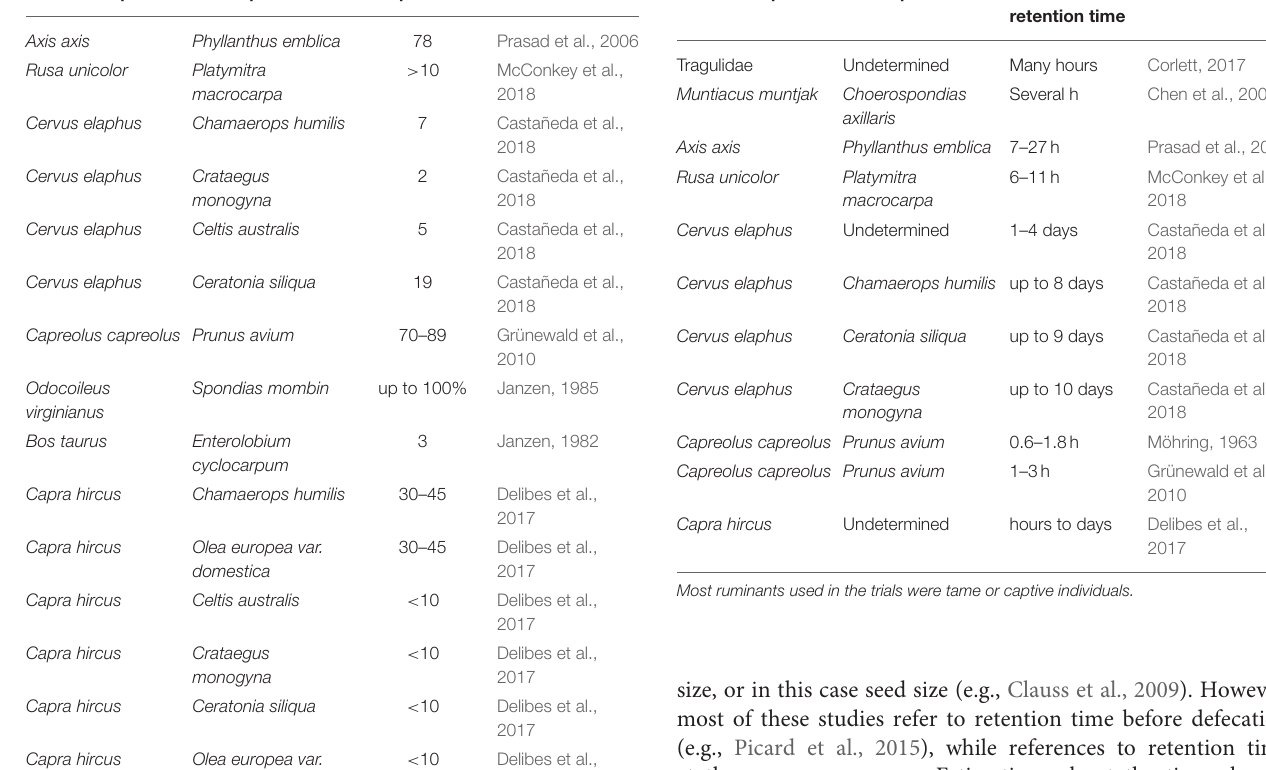
TABLE 3 | Percentages of the ingested seeds of several plant species that were spat from the cud by domestic and wild captive ruminant species. Ruminant species Plant species